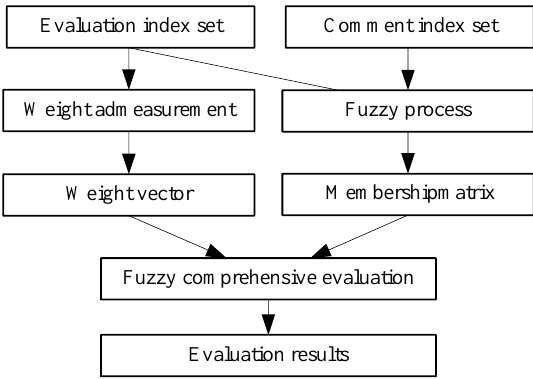
Figure 1. The general process of the single-level model of fuzzy comprehensive evaluation.